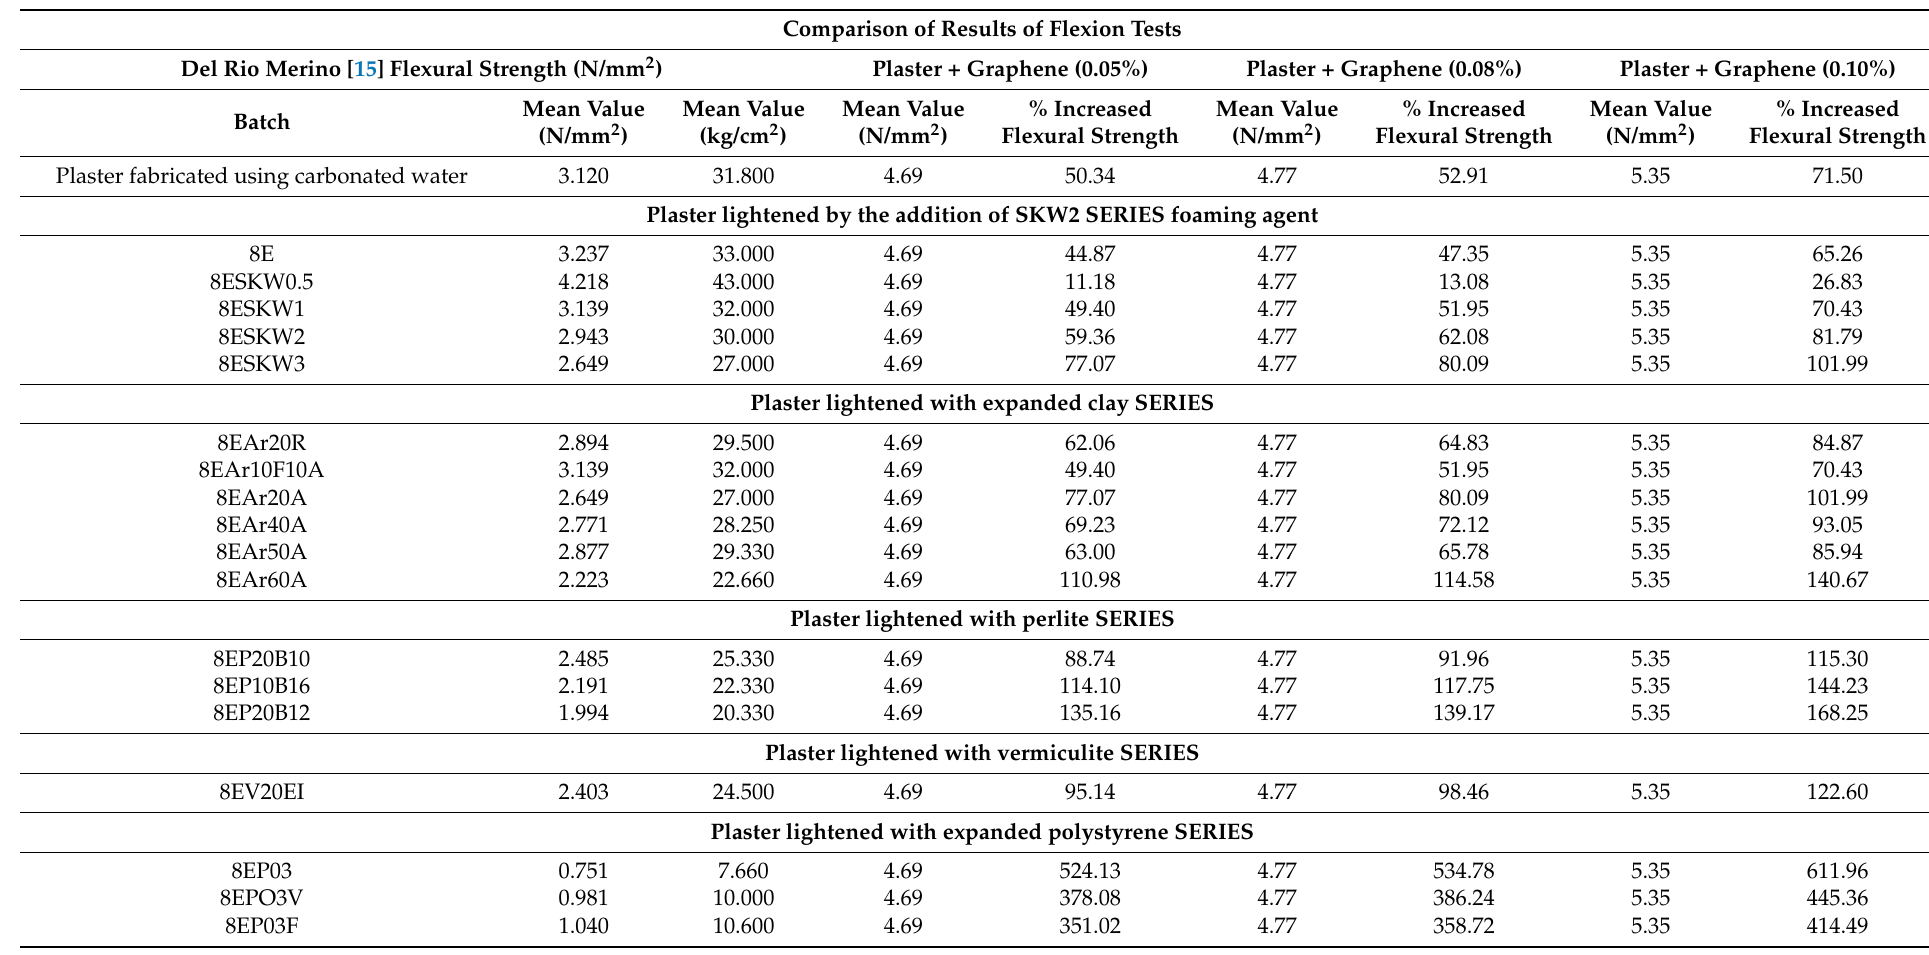
Table 10. Comparison of flexural strength test results of gypsum mortar with graphene powder with those reported by del R í o Merino [15]. Comparison of Results of Flexion